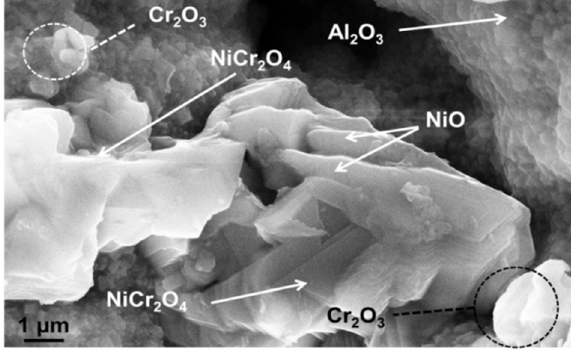
Figure 9. A localized area on oxidized coating top-surface characterized by the presence of mixed oxides grown on the surface of Al 2 O 3 grains. NiO and spinels show polygonal and equiaxed shape, respectively.